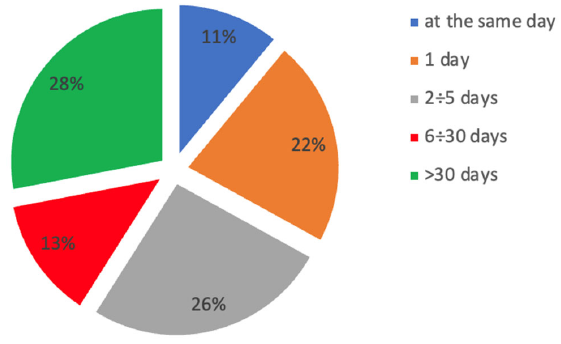
Figure 3. Classi fi cation of damage according to the method of repair.